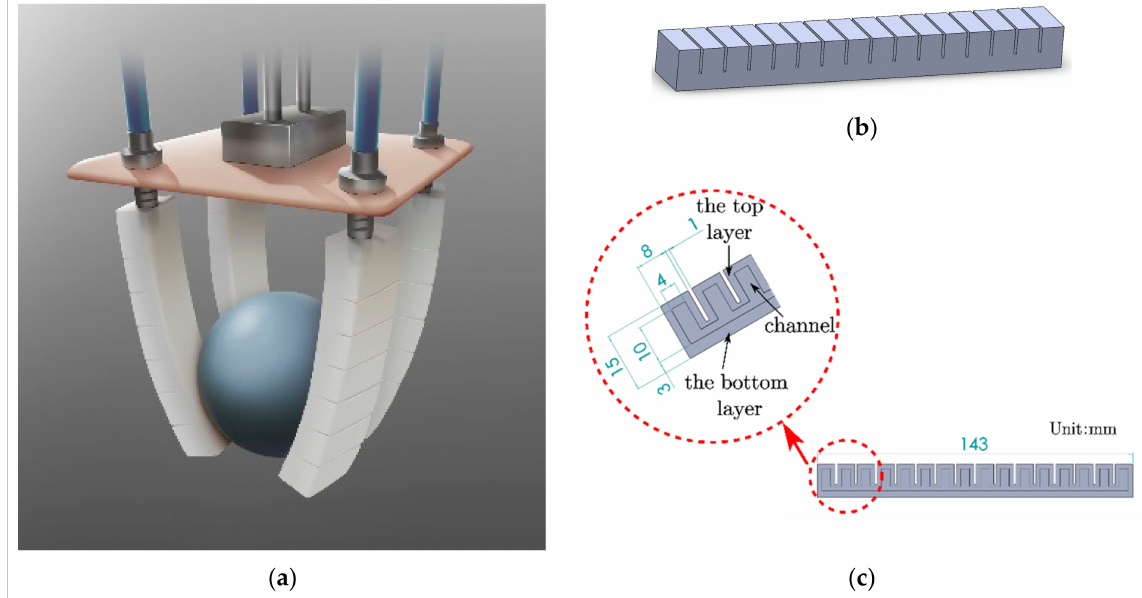
Figure 1. ( a ) A schematic of the soft manipulator grasping a sphere; ( b ) 3D model of the soft manipulator; ( c ) profile of the soft